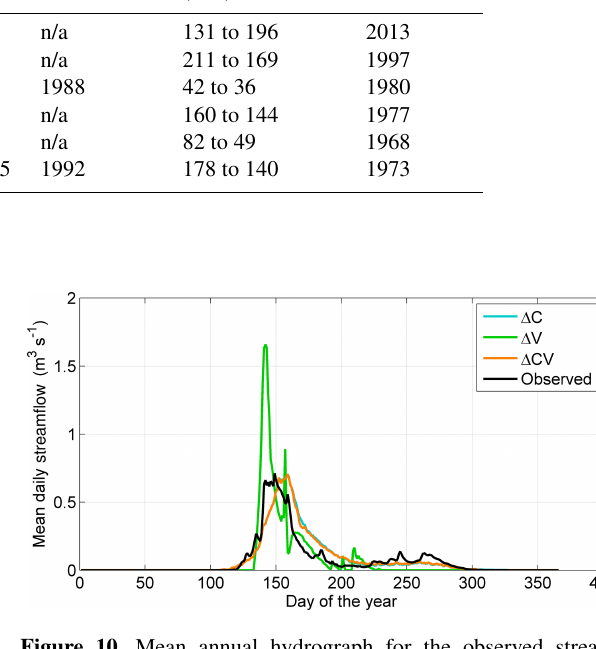
Figure 10. Mean annual hydrograph for the observed stream- flow (1995–2015), and the three modelling scenarios (1960–2016): changing climate-only ( (cid:49) C), changing vegetation-only ( (cid:49) V) and changing climate and vegetation ( (cid:49) CV). Note the overlap between the (cid:49) C and (cid:49) CV